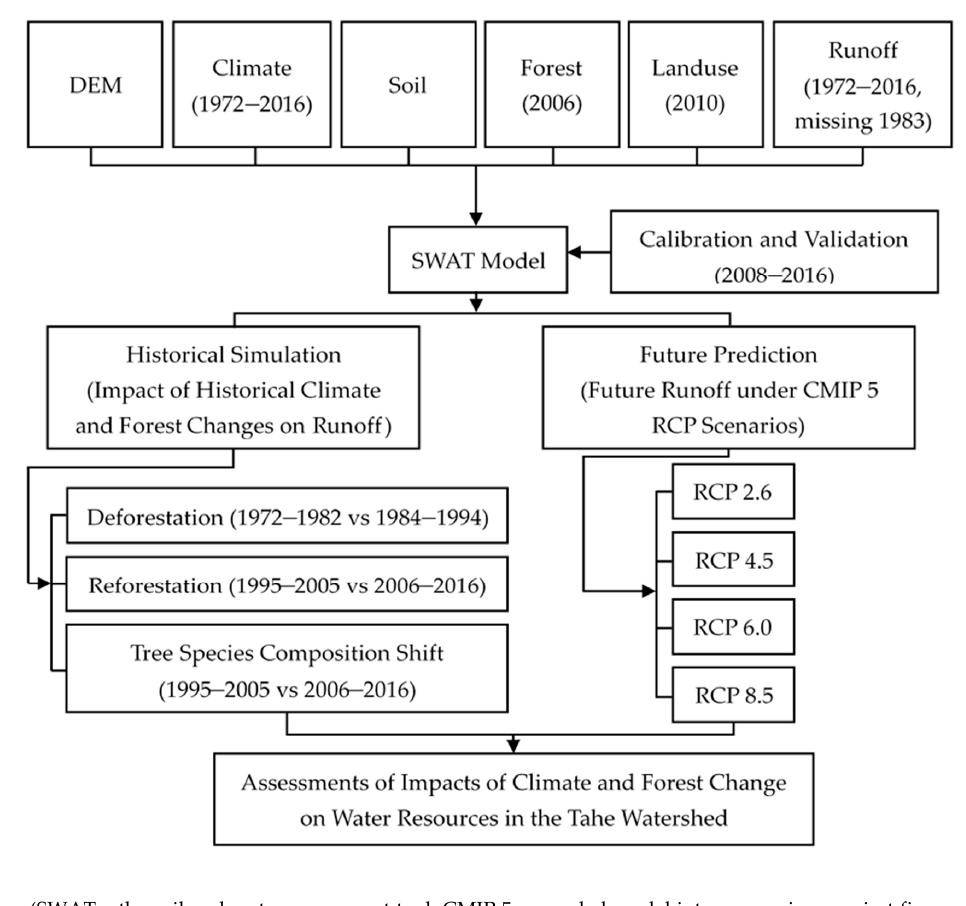
Figure 2. Technical route.